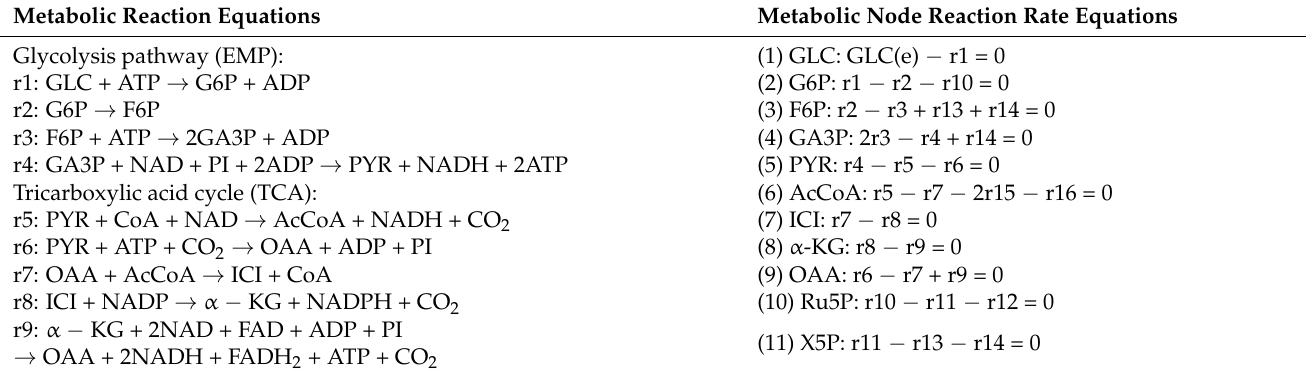
Table 1. Metabolic reaction equations and metabolic node reaction rate equations of ganoderic acids R, S and T’s synthesis from submerged fermentation-static culture of G. lucidum